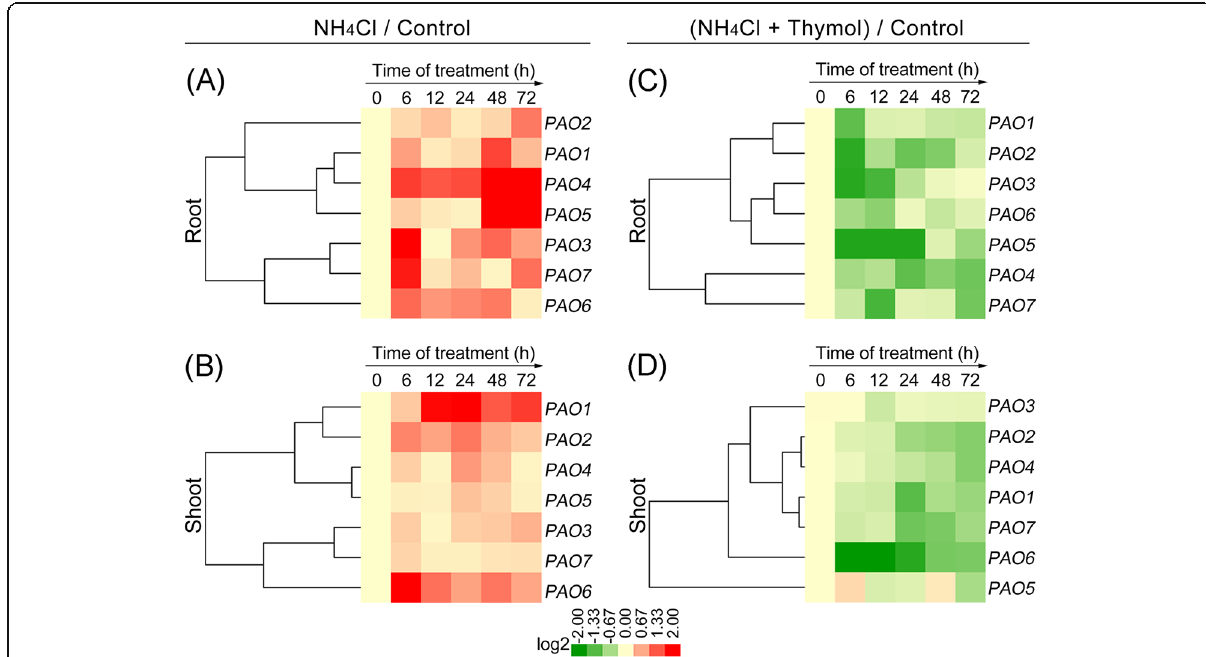
Fig. 4 Thymol repressed ammonium-induced upregulation of PAOs in rice seedlings. a and b Relative expression level of PAOs in NH 4 Cl-treated seedlings with respect to control. c and d Relative expression level of PAOs in seedlings treated with NH 4 Cl + thymol with respect to NH 4 Cl treatment alone. Red and green indicate up-regulation and down-regulation,